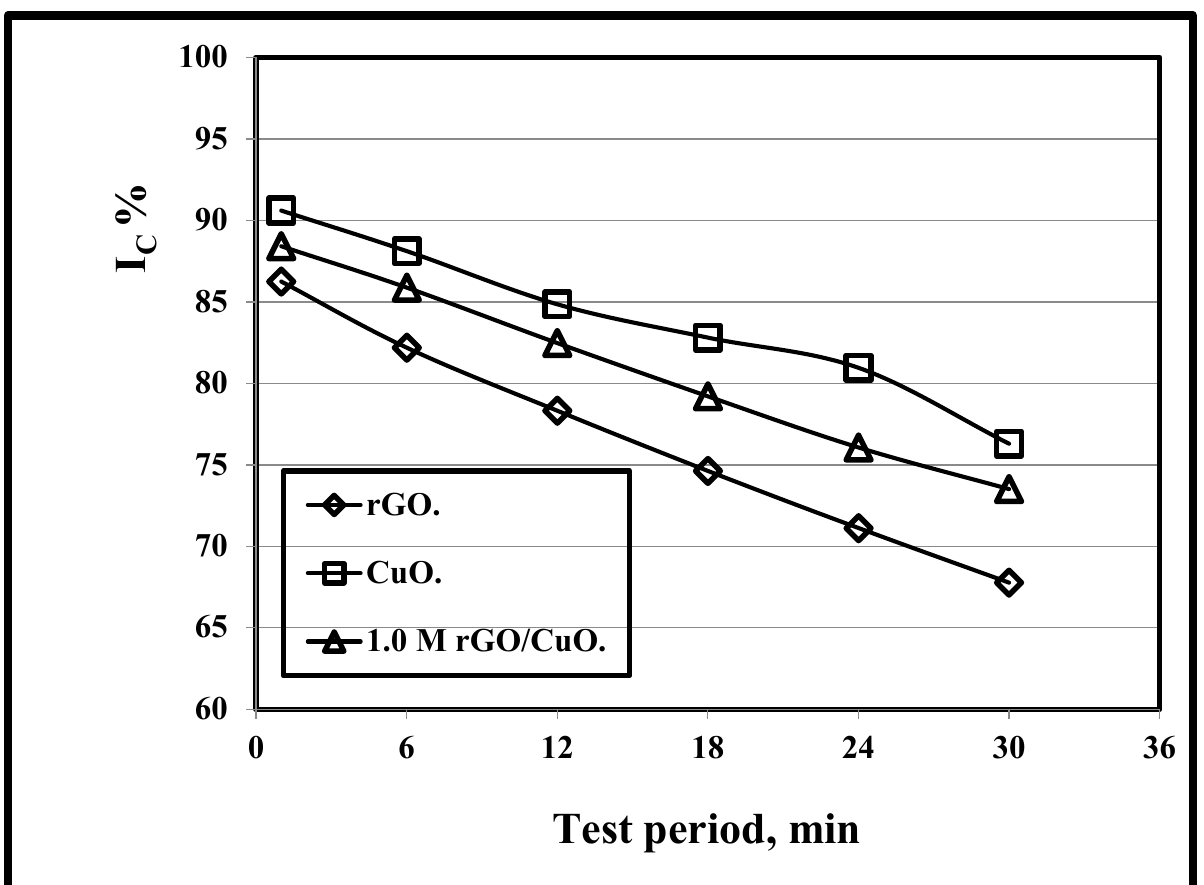
Figure 3. Variation of I c /test period at rGO, CuO, and 1.0 M rGO/CuO and 500 °C.